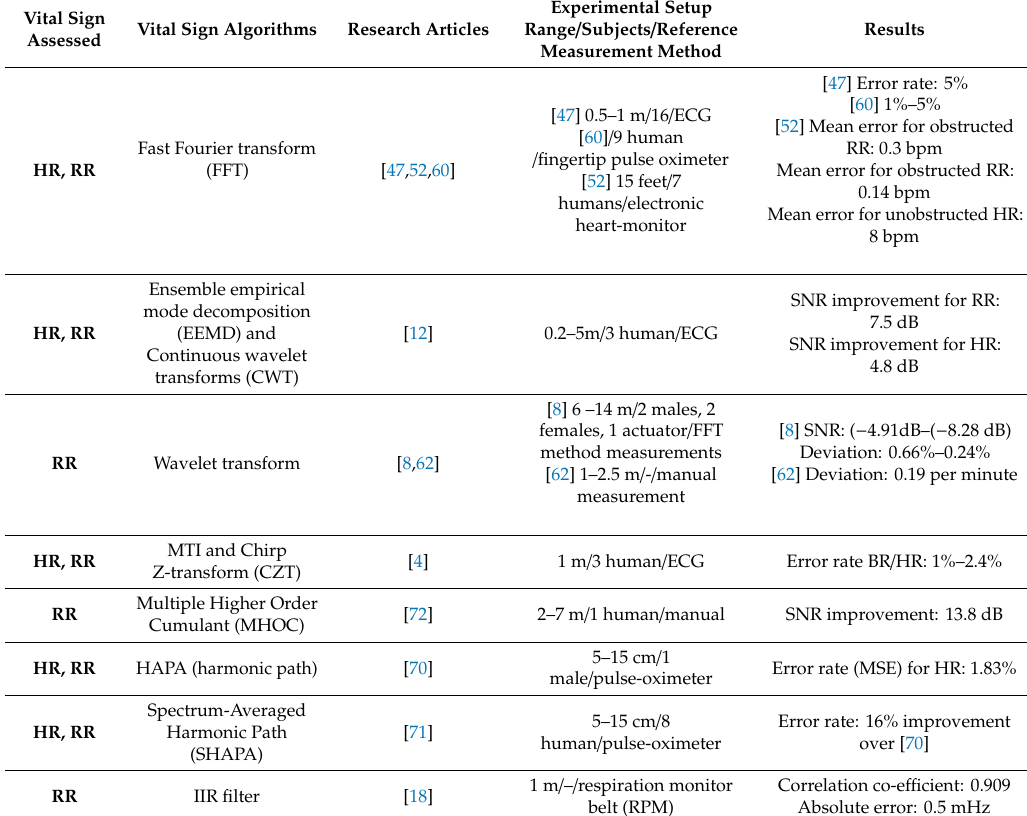
Table 2. Performance comparison of vital sign detection